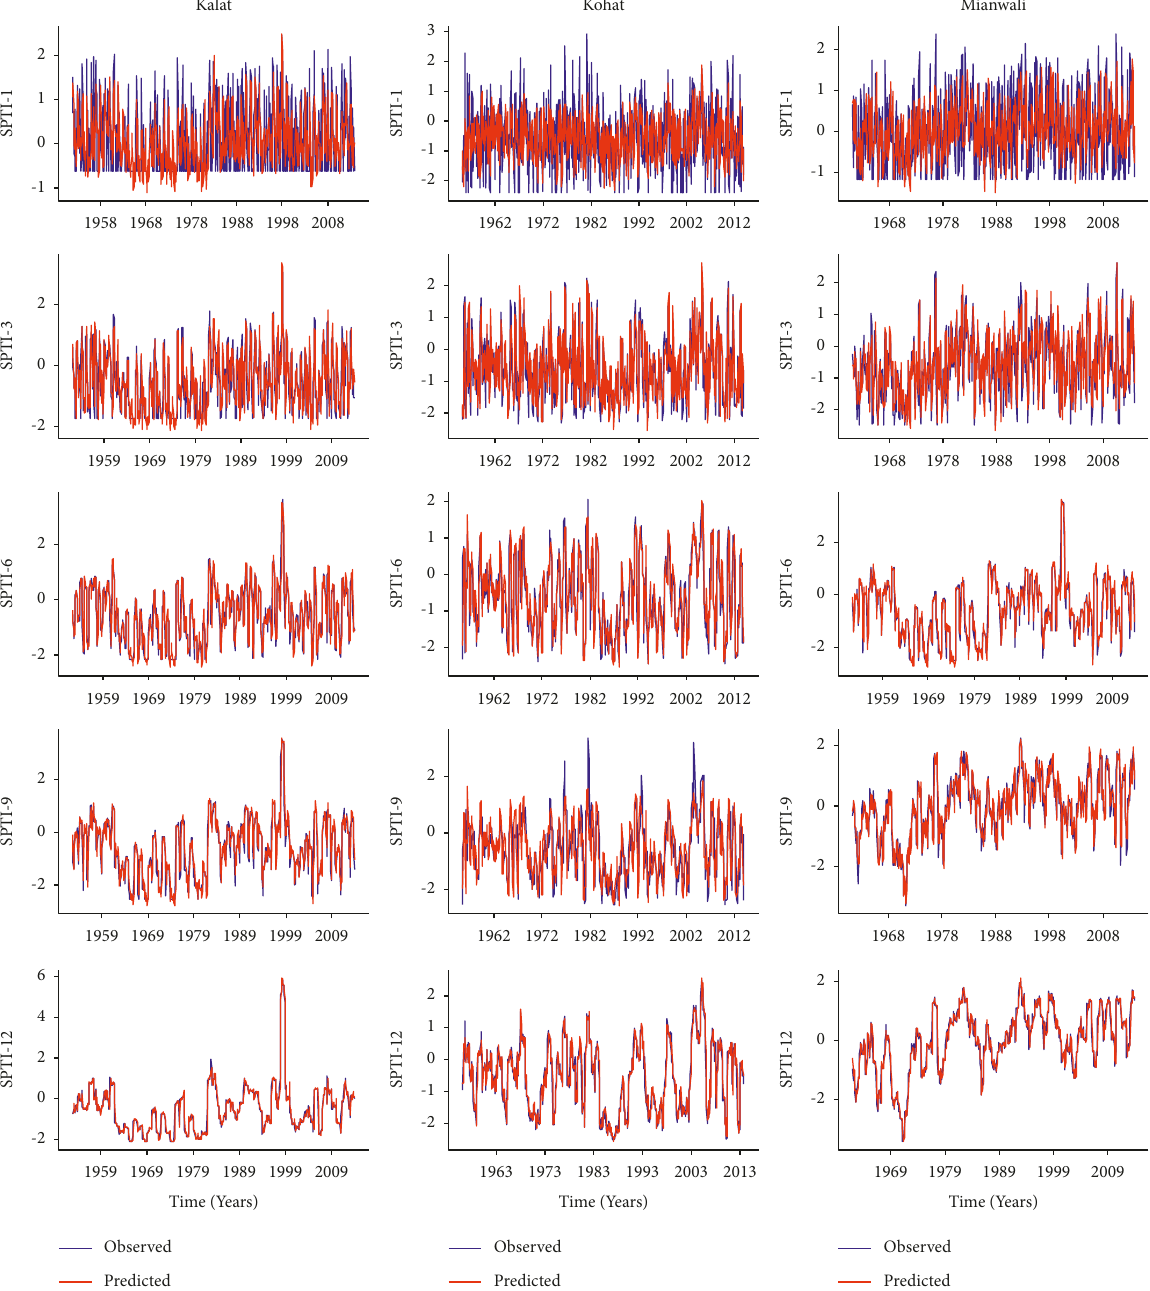
Figure 6: Co-movement of the observed and predicted values of SPTI using ELM at Kalat, Kohat, and Mianwali stations for the training